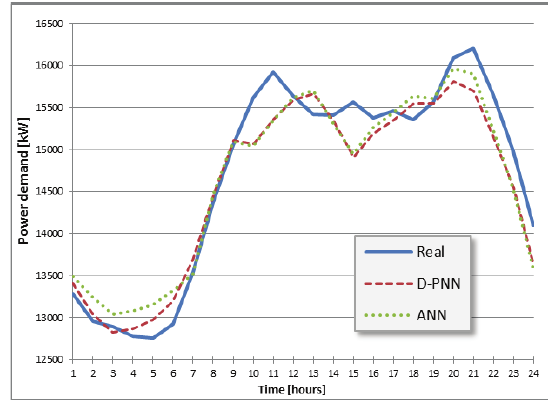
Fig. 16. IESO : 13.5.2012 (Sunday). D-PNN RMSE = 317.4 , ANN RMSE =